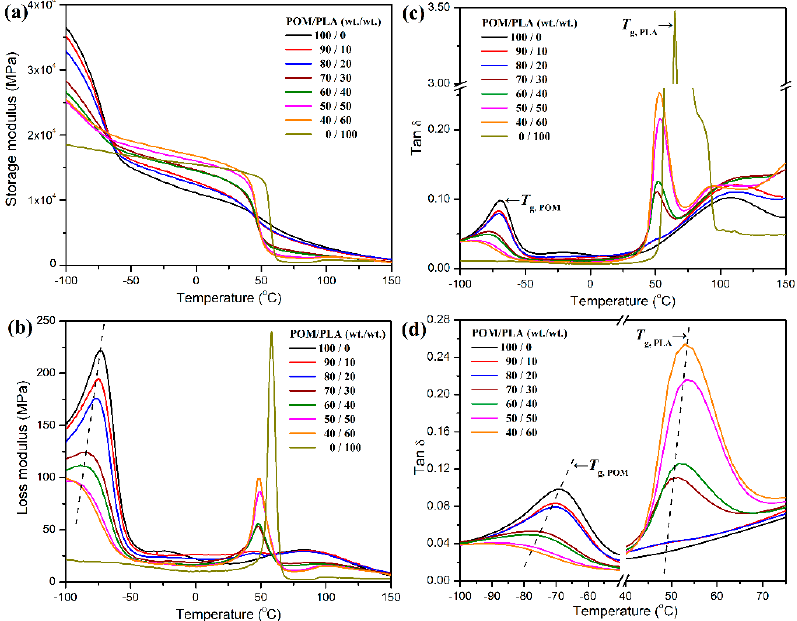
Figure 6. ( a ) Storage moduli, ( b ) loss moduli, and ( c , d ) loss factors (tan δ ) of pure POM, pure PLA, and their blends as a function of temperature.